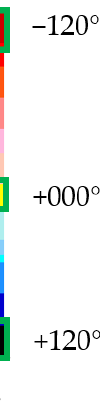
Figure 9. Comparison of the error rate of LBPH with different ambient light levels.